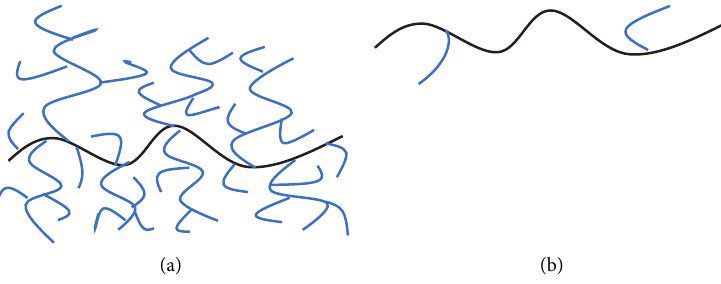
Figure 5: Schematic representation of the structure of (a) LDPE and (b)